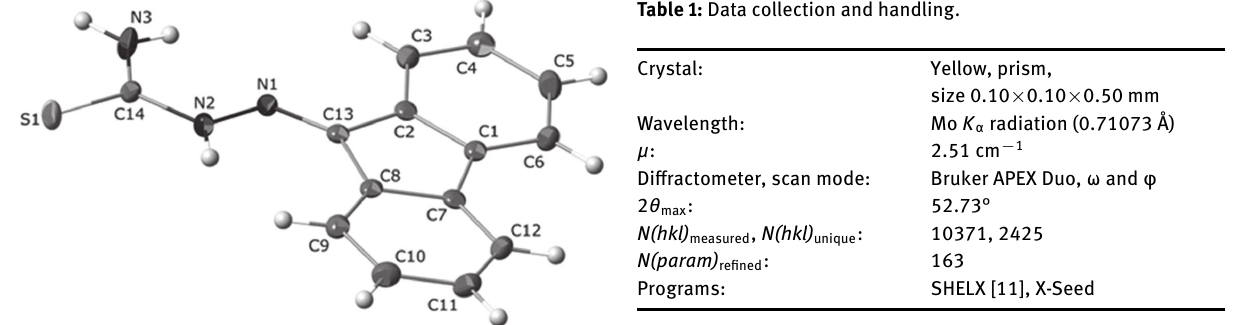
Table 1: Data collection and handling.